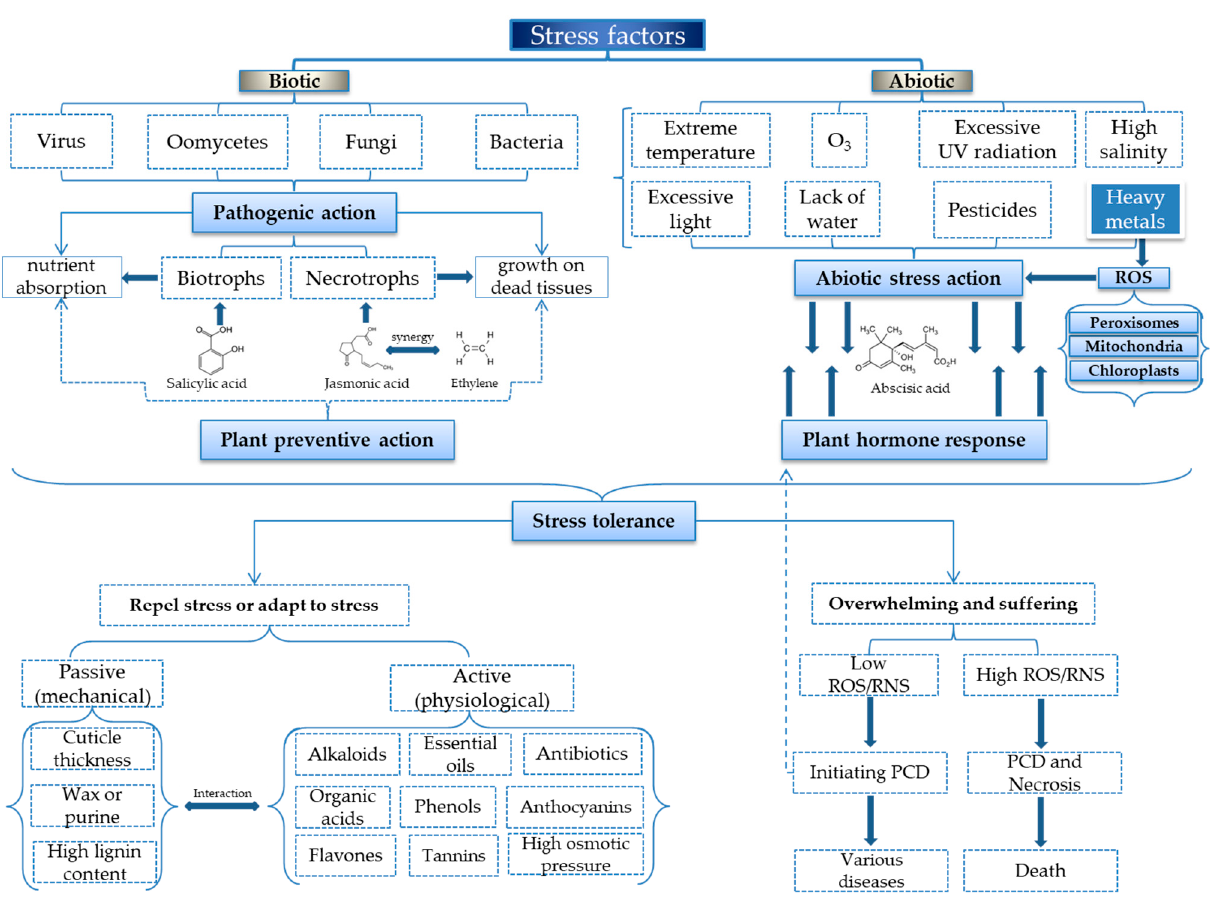
Figure 4. Schematic representation of stress factors, their action on plants/herbs and defense mechanisms.